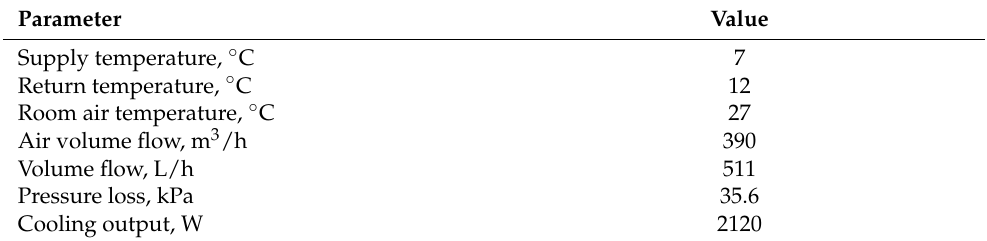
Table 4. Nominal operation parameters for the fan coil unit (FCU).